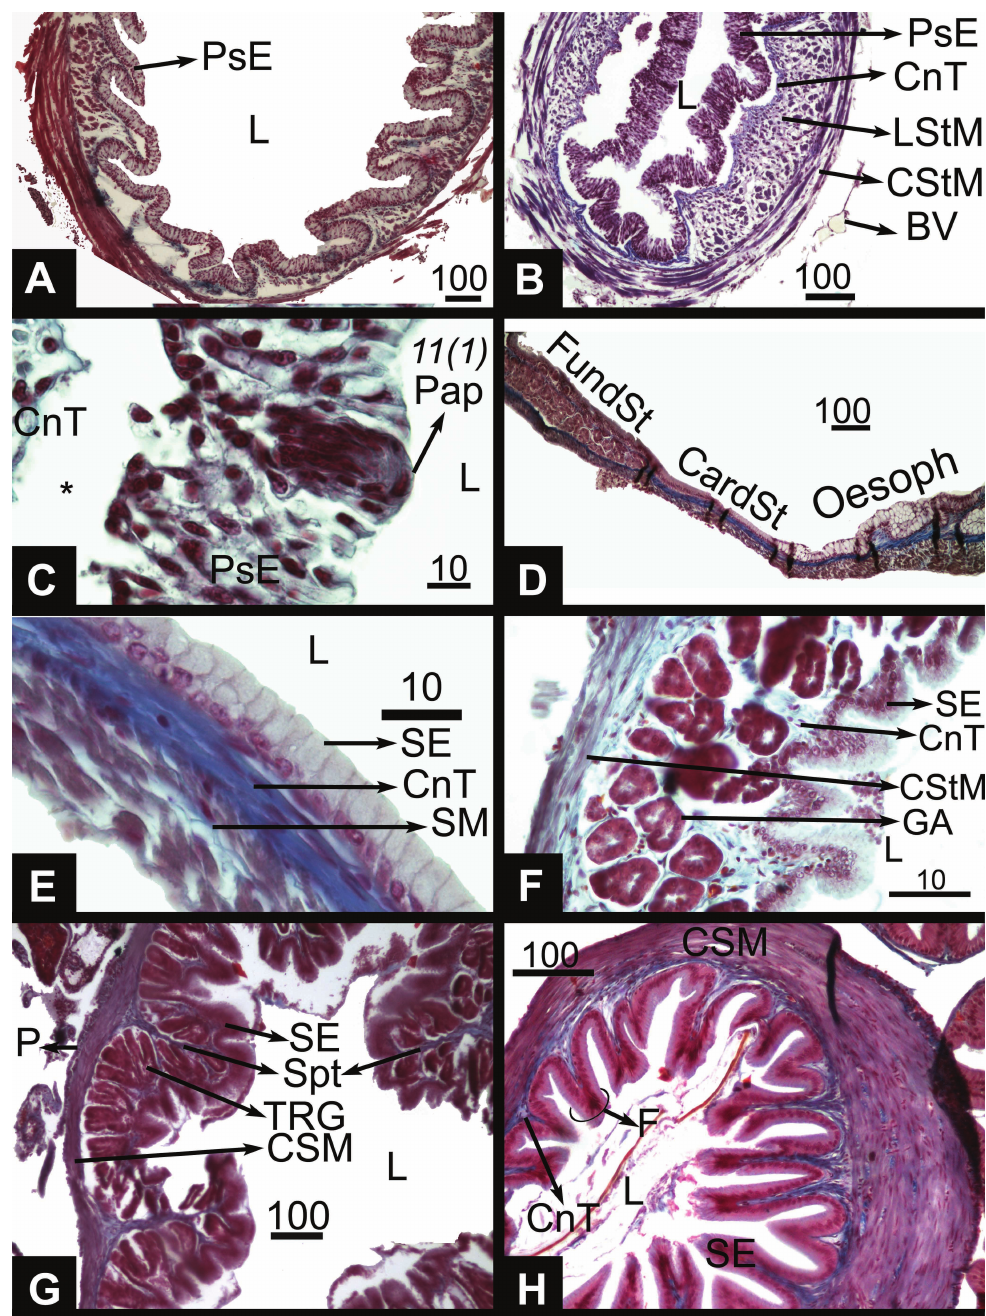
Fig. 5. Histological sections of the alimentary tract of selected species of the Characidae family: A - Astyanax rutilus esophagus in transversal section showing a folded esophagus mucosa; B - Cheirodon interruptus esophagusin transversal section showing less conspicuous foldings and a proportionally greater development of the musculature; C - Gustative papillae detail of Cheirodon interruptus. Characters are indicated with numbers and character states between parentheses; D - Transition esophagus-stomach of Gymnocorymbus ternetzi in longitudinal section; E - Cardiac stomach of G. ternetzi in longitudinal section; F - Anterior portion of the fundic stomach of Aphyocharax anisitsi in transversal section with acinous glands; G - Posterior portion of the fundic stomach of A. anisitsi in transversal section showing developed connective tissue septa and tubular ramified glands. H - Pyloric portion of G. ternetzi intestine in transversal section. Abbreviations= BV : Blood vessel; CardSt : cardiac stomach; CnT : connective tissue; CSM : Circular smooth muscle; CStM: Circular striated muscle; F : folding; FundSt : fundic stomach; GA : Acinous Gland; L : lumen; LStM : Longitudinal striated muscle; Oesoph : Oesophagus. P : peritoneum; Pap : papillae; PsE : Pseudoestratified epithelium; SE : Simple Epithelium; SM : Striated muscle; Spt : Septum; TRG : Tubular Ramified Gland; * : space generated by a technical artifact. Bars